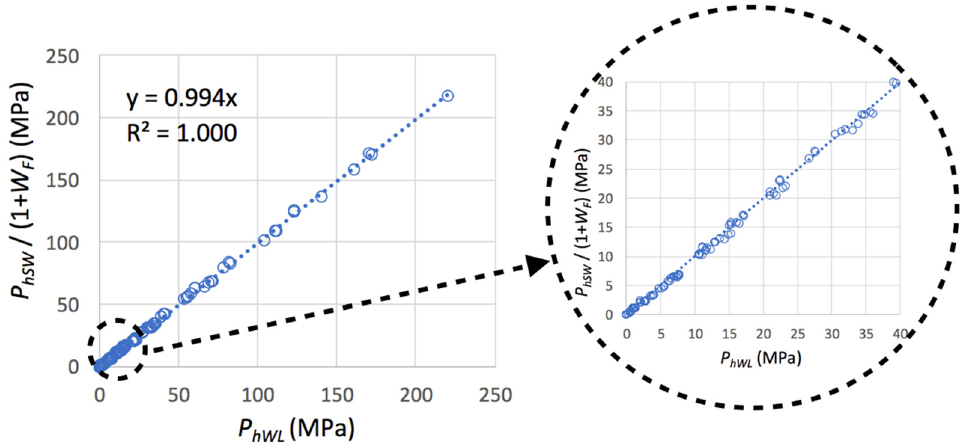
Figure 17. Correlation obtained between the numerical results applying the self-weight coefficient Equation (14).